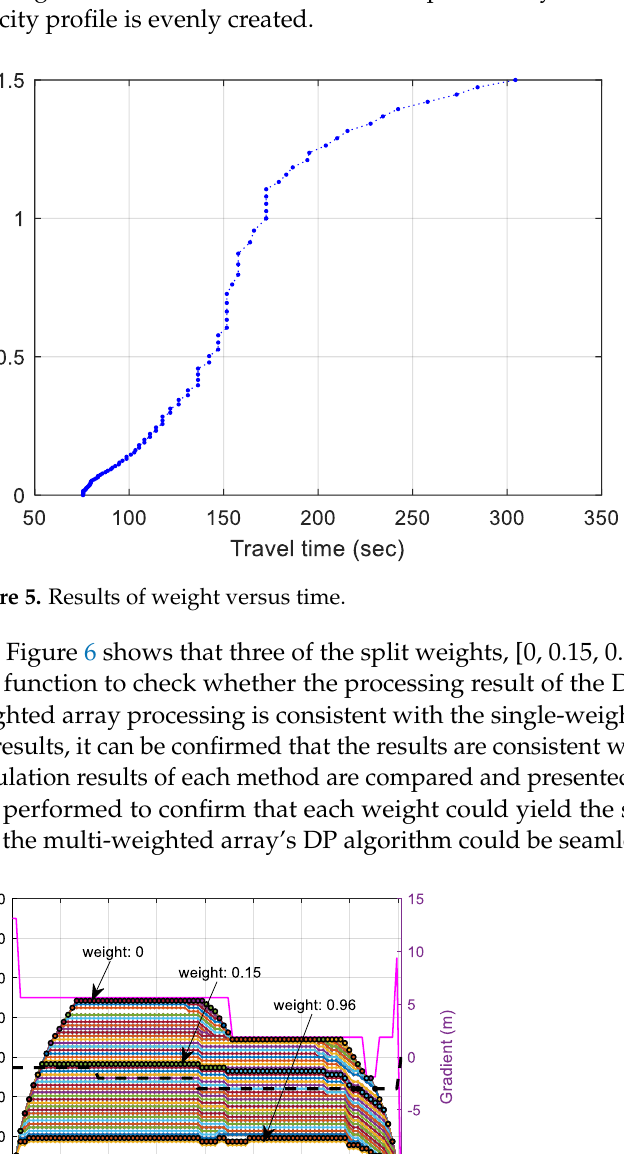
Figure 6. Comparison of multi-weighted and single-weighted DP results. Table 6. Comparison of single-weight and multi-weight calculation